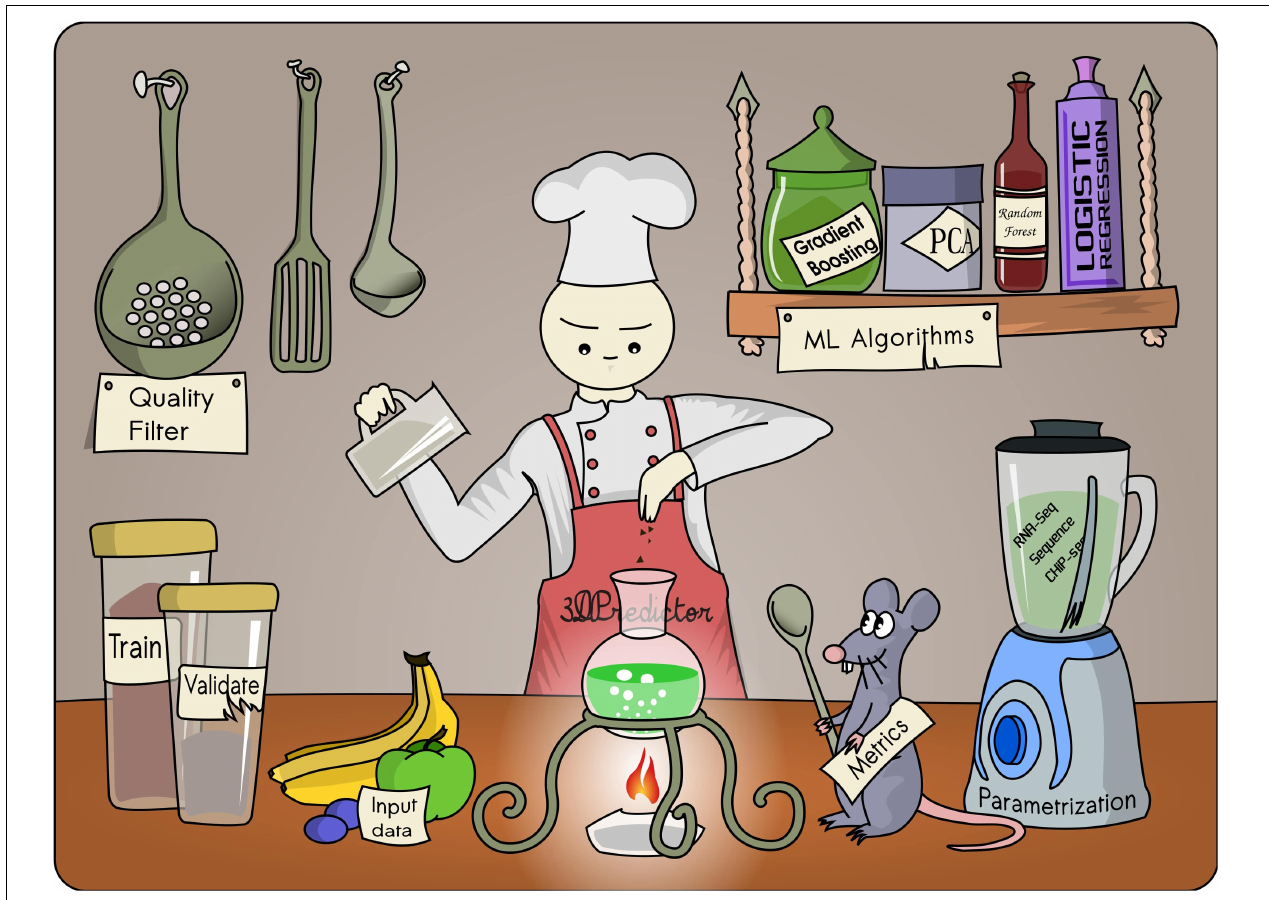
FIGURE 2 | In designing a machine learning–based algorithm, one should carefully choose the main “ingredients” required for good